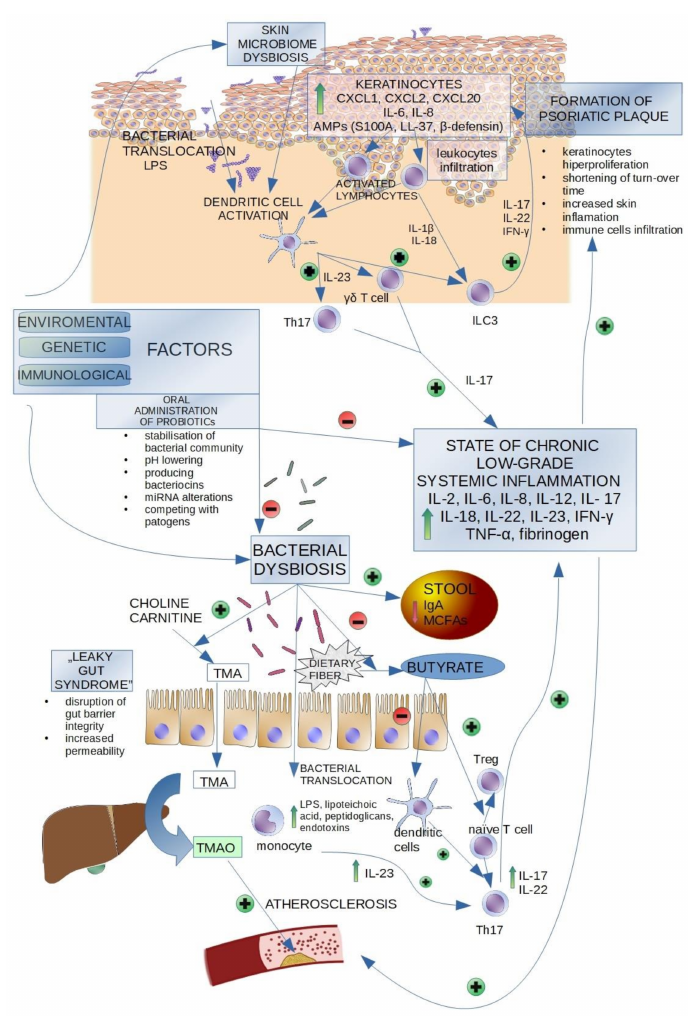
Figure 1. Gut and skin microbiome dysbiosis and its impact in